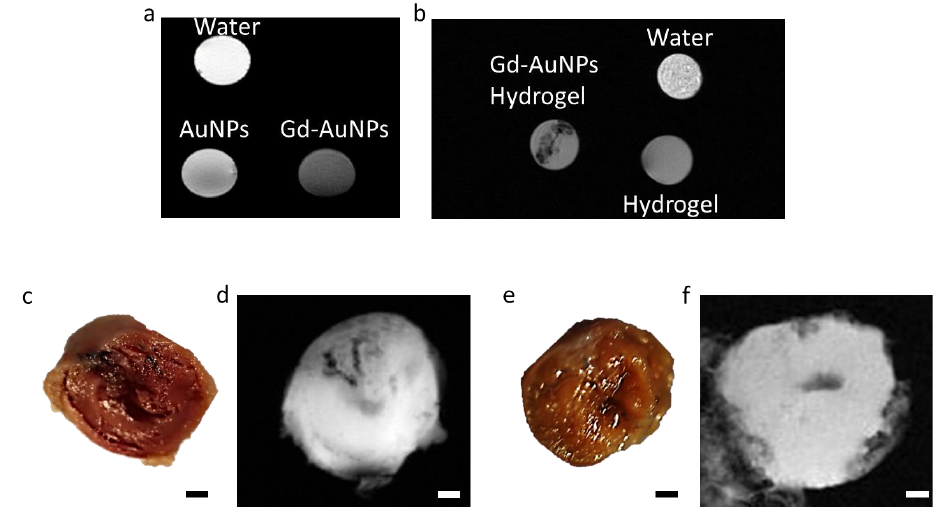
Figure 5. Detection of the nanocomposite hydrogel by MRI. ( a ) MRI imaging of AuNP-Gd, AuNP, and water solutions. ( b ) MRI imaging of droplets of the nanocomposite hydrogel, pristine hydrogel, and water. ( c – f ) Images of the heart slice ( c , e ) and ex vivo MRI imaging ( d , f ) of the treated ( c , d ) and untreated ( e , f ) hearts, 6 weeks post IRI surgery; scale bar = 1 mm.